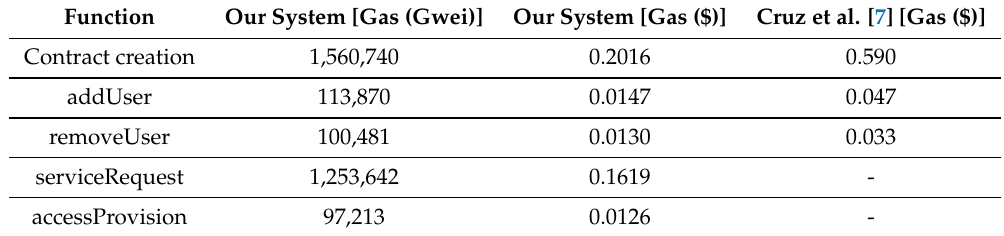
Table 1. Cost of different functions of the smart contract based on Gas (both Gwei and USD ($)) rates.